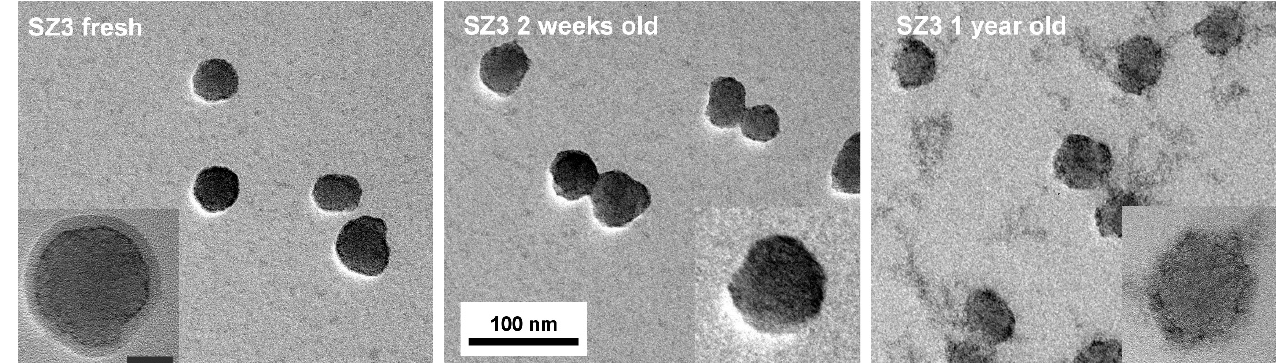
Figure 1. TEM pictures of batch SZ3 in ethanol showing an incomplete condensation of the zirconia precursor on the day after addition to the silica cores ( left ), completed ZrO 2 shell formation and beginning of the ripening at the age of 2 weeks ( middle ) and the advanced ripening of the 1-year-old core@shell NPs leading to the dissolution-redeposition of the material next to the NPs ( right ).